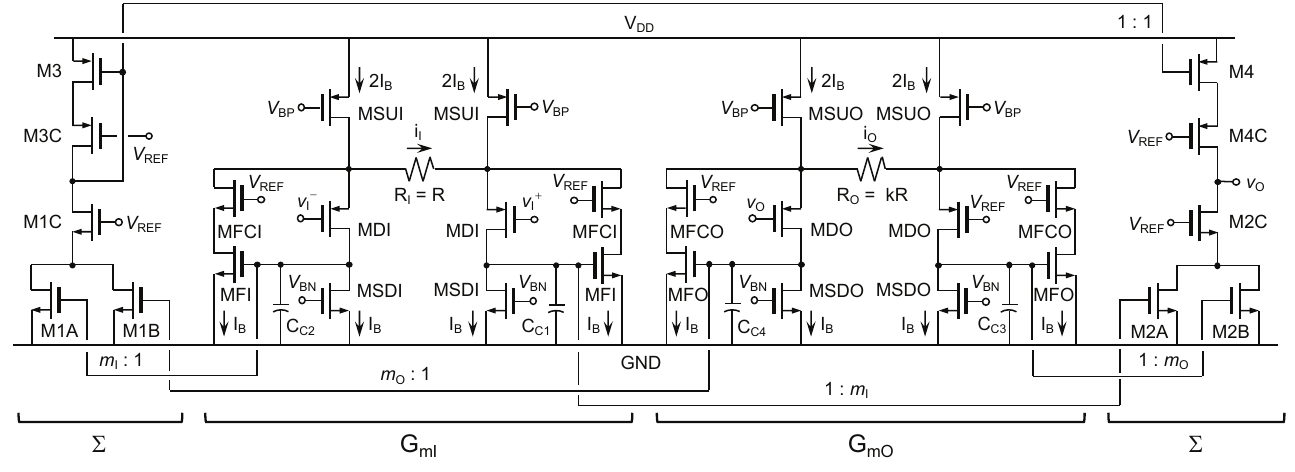
Figure 3. Transistor level implementation of the proposed single-ended ICF